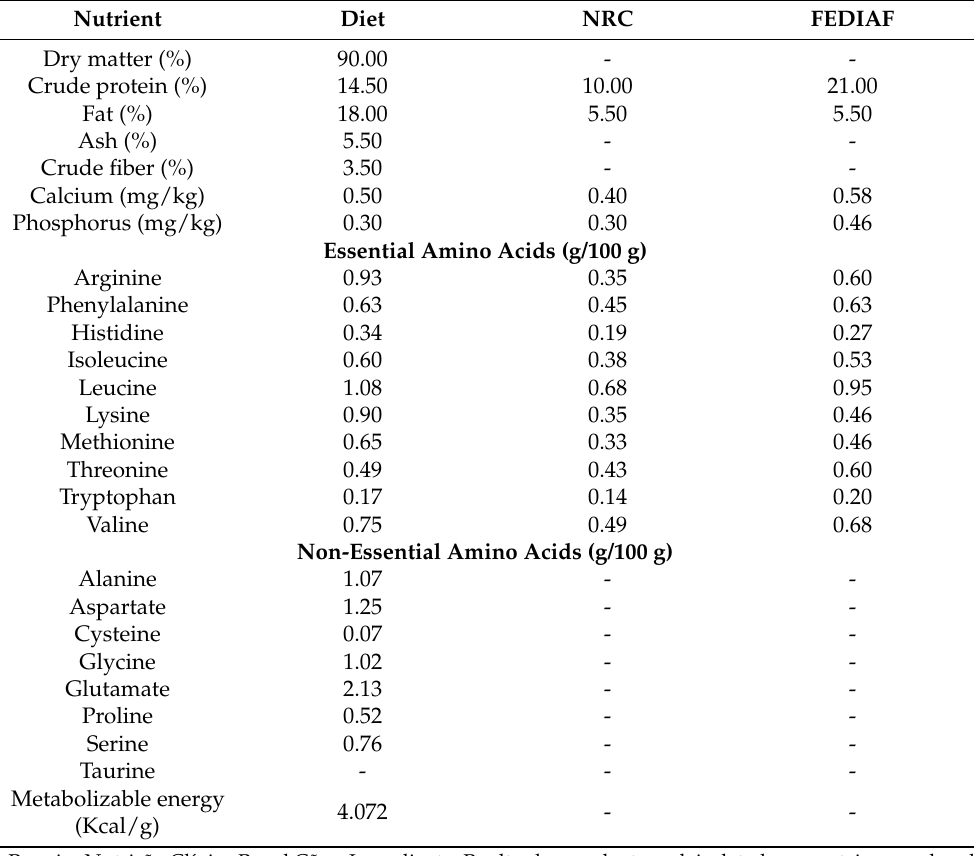
Table 4. Chemical composition in percentage of dry matter and amino acid profile of the com- mercial renal diet used 1 and National Research Council [37] and European Pet Food Industry Federation [38]